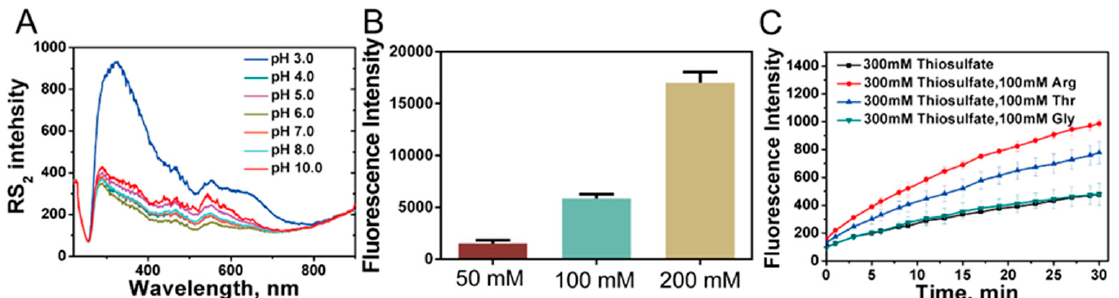
Figure 6. The effects of Arg and Thr on spontaneous decomposition of thiosulfate. ( A ) Thiosulfate was dissolved in pH buffers of different pH (3.0–10.0). RS 2 was measured after a 30 min incubation at 25 ◦ C. ( B ) Thiosulfate was reacted with SSP4 at pH 3.0 condition. ( C ) Thiosulfate was reacted with SSP4 at pH 4.0 condition, with or without presence of Arg, Thr or Gly.